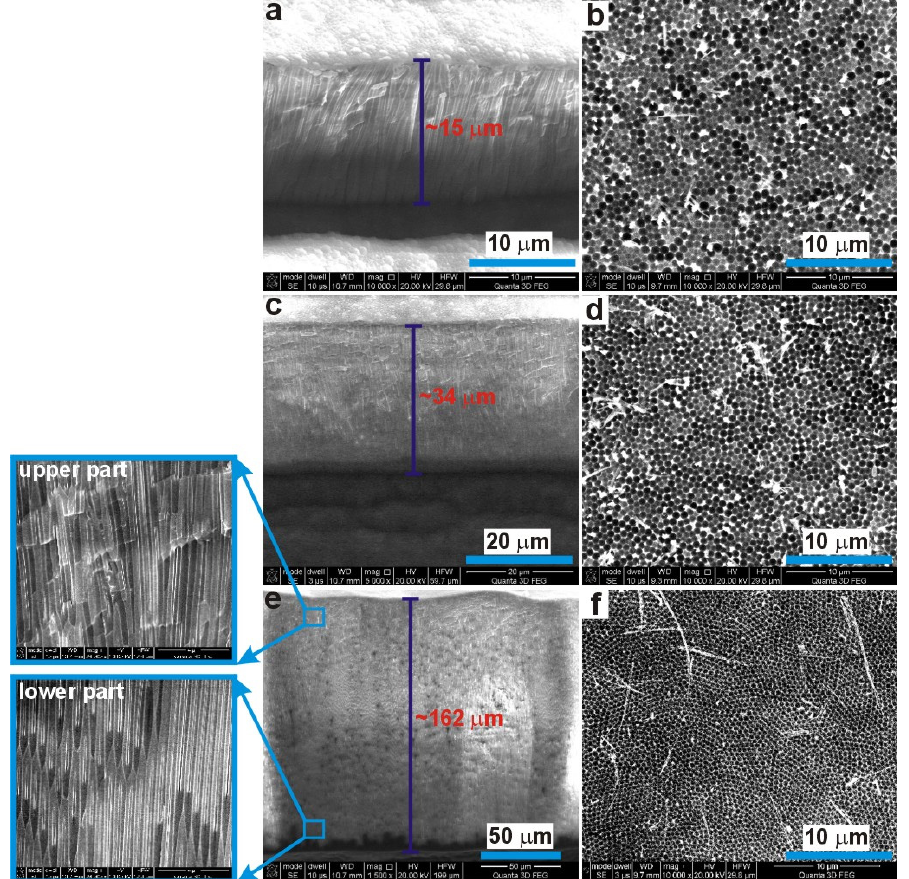
Figure 4. The SEM images of a cross-sectional view of AAO ( a , c , e ) and corresponding nanoconcaves left on aluminum surface after AAO dissolution ( b , d , f ) for the samples anodized under 300 V for 8 h in 0.15 M ( a , b ), 300 V for 7 h in 0.25 M ( c , d ), and 250 V for 6 h in 0.5 M ( e , f ) malic acid solutions at 5 °C.